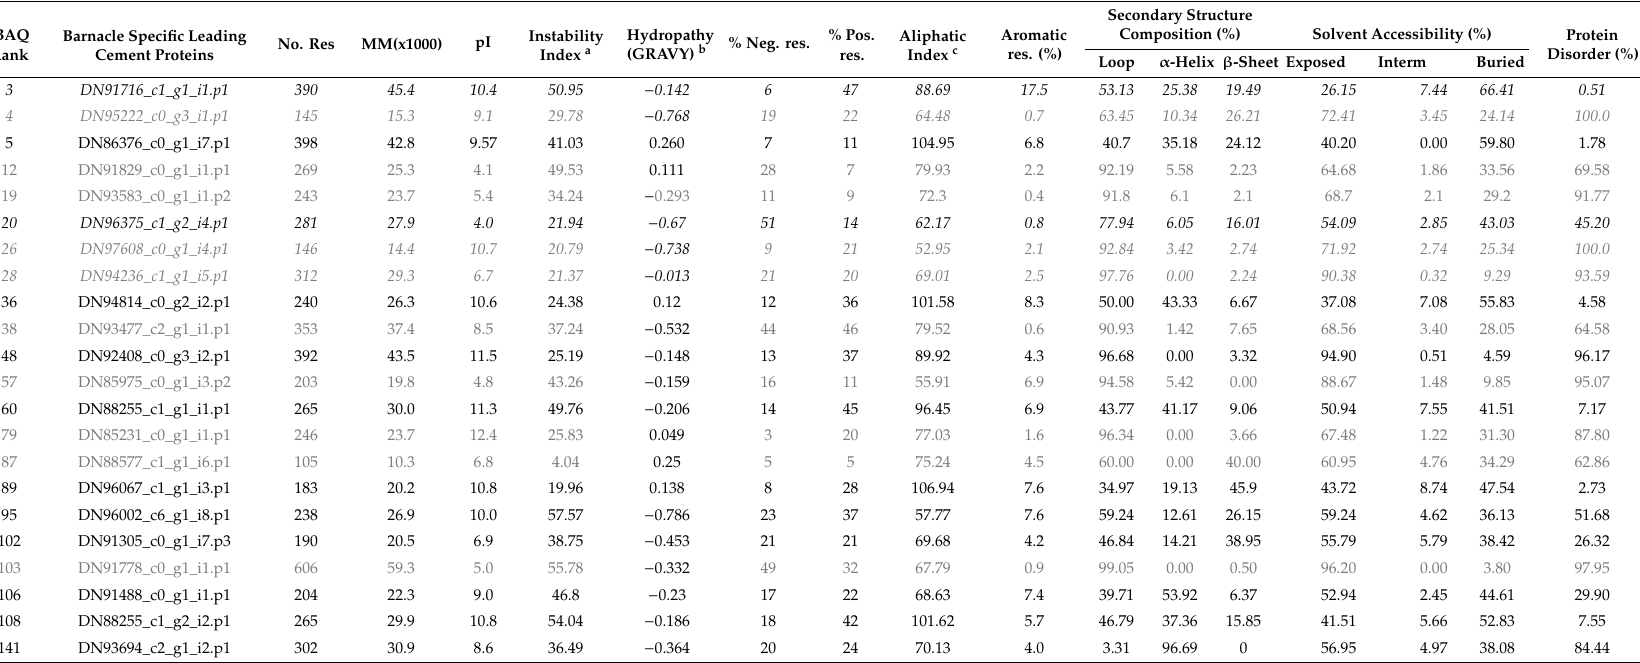
Table 1. Characteristics of the 21 unannotated proteins identified in Pollicipes pollicipes cement proteome, and of a new CP protein annotated as 52k-like (DN93583_C0_g1_i1.p2), ranked according to the intensity-based absolute quantification (iBAQ) value. No. Res – number of residues; MM – molecular mass; pI – isoelectric point; Neg. res. – negative residues (sum of Asp and Glu); Pos. res. - positive residues (sum of Arg, His and Lys);. In grey are proteins that have clustered with the adhesive proteins of group 1 (G1; surface-coupling proteins). iBAQ